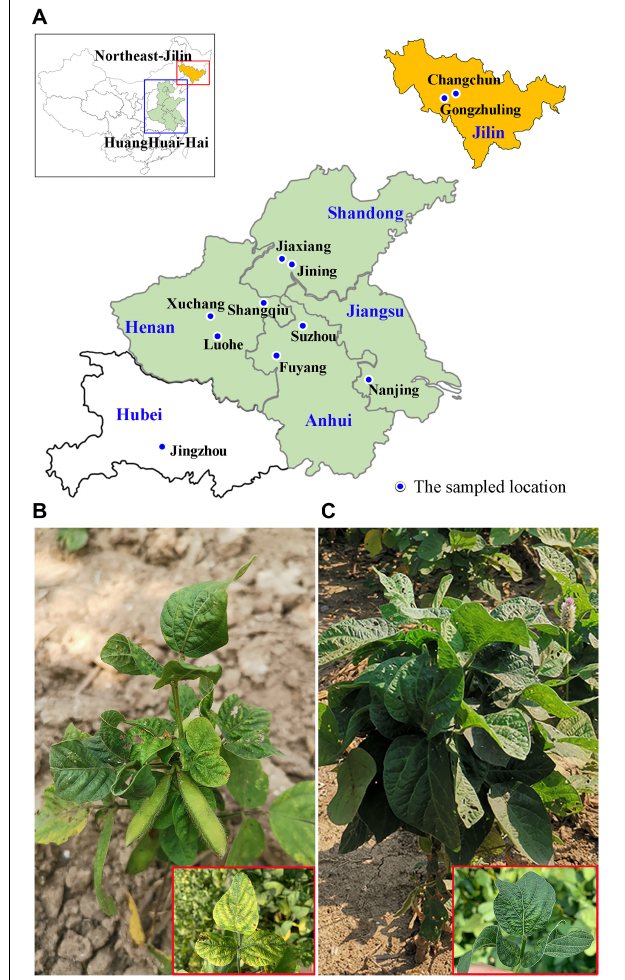
FIGURE 1 | The geographical locations of the symptomatic soybean samples collected in China and the symptoms on leaves of the sampled plants. (A) Map of China (top left corner) showing the study area (red and blue rectangular box). The 11 sampled fields are marked on the enlarged abridged map. (B,C) Leaves of soybean plants displaying typical yellow mosaic (B) and crinkling (C) virus-like